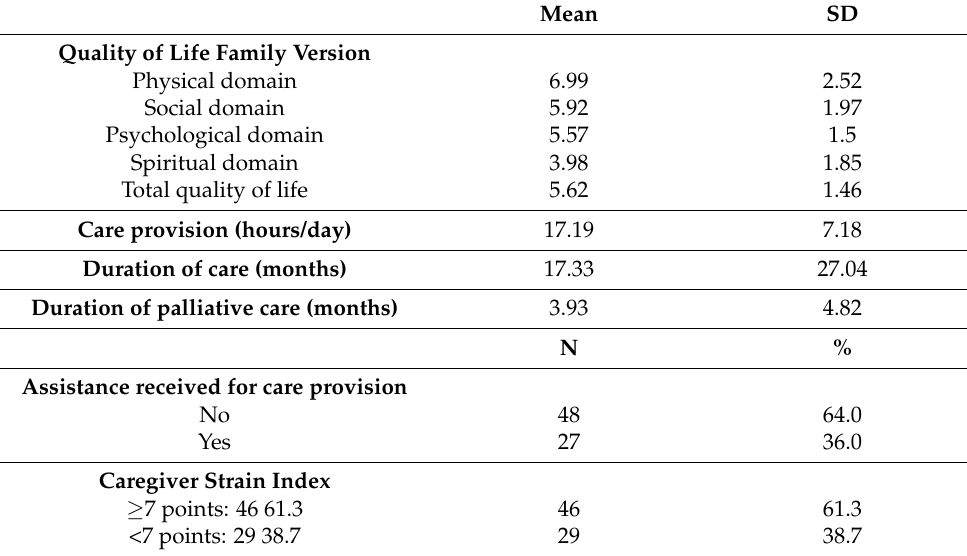
Table 3. Strain and quality of life of the family caregivers (n =